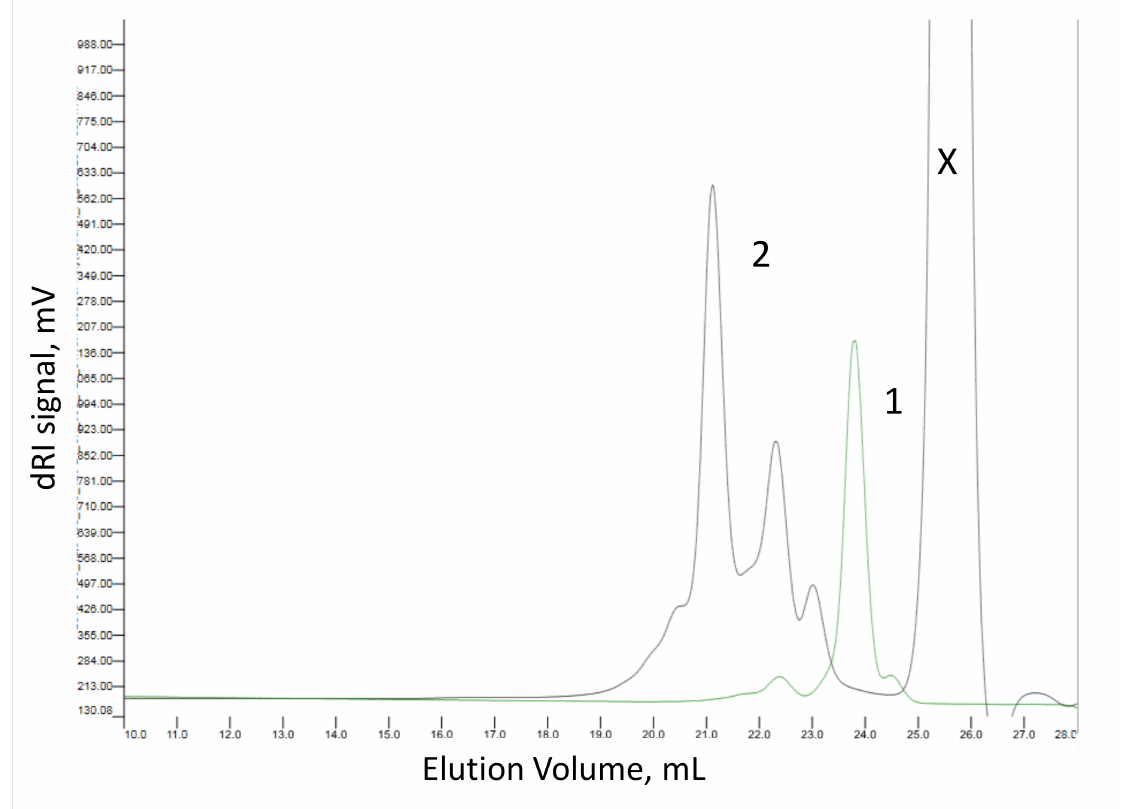
Figure 4. SEC traces of MDBPO monomer (1, green trace) and polymer PMDBPO (2, black trace). X—internal standard. See experimental for analysis